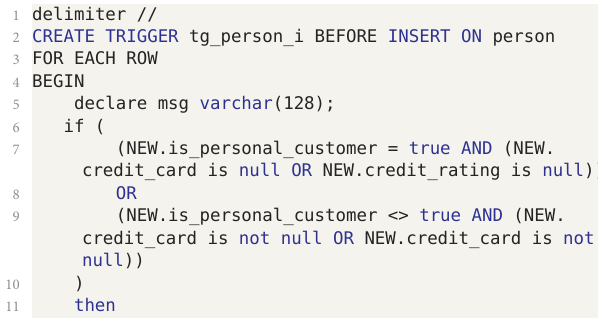
is updated to Organization . In all cases filters are added to identify the subclass in the